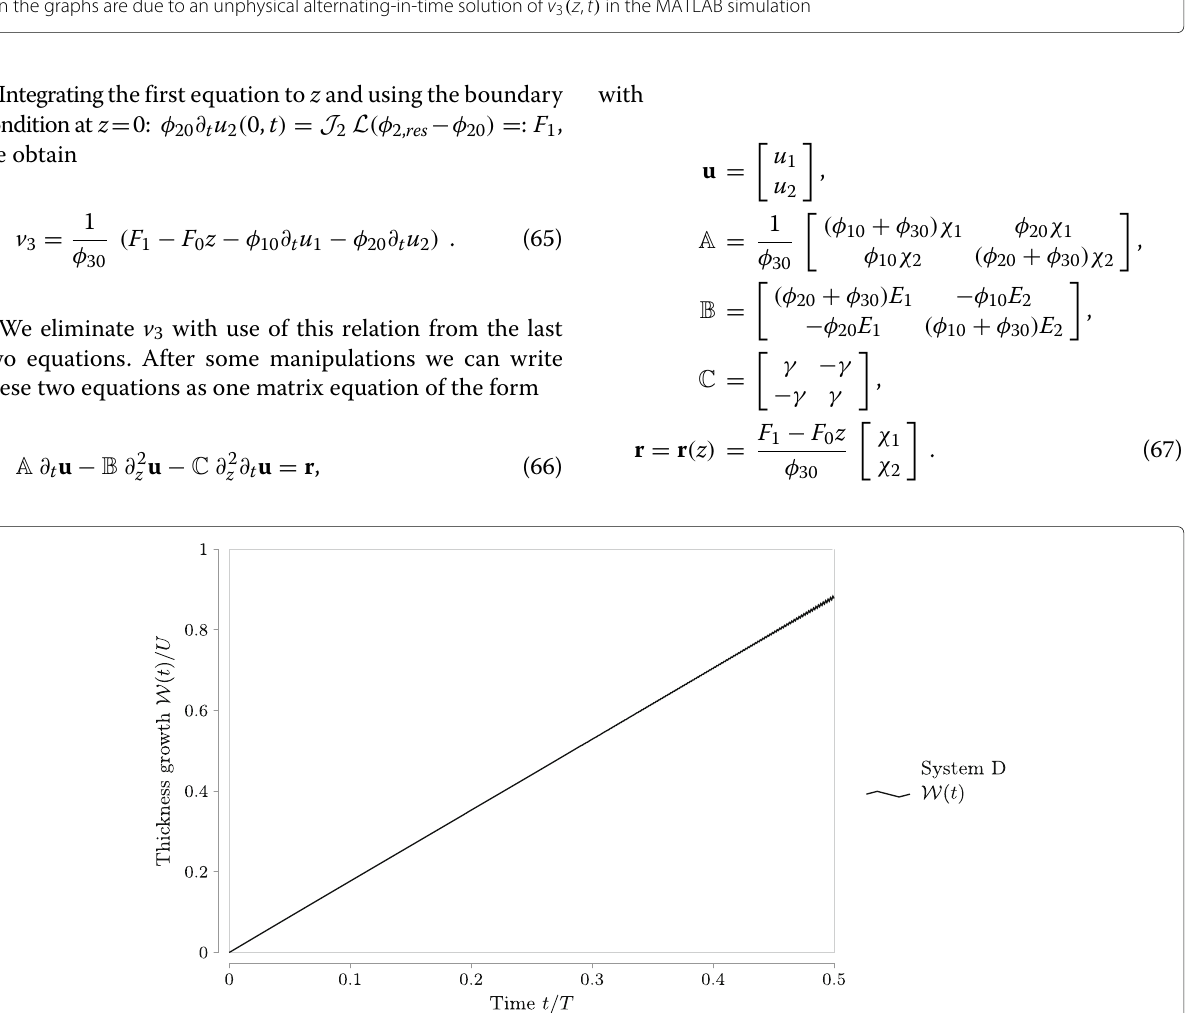
Fig. 8 MATLAB simulation of W ( t ) for A 1 = A 2 = 0 and the other parameters with the values of Table 1. The oscillations in the graphs are due to an unphysical alternating-in-time solution of v 3 ( z , t ) in the MATLAB